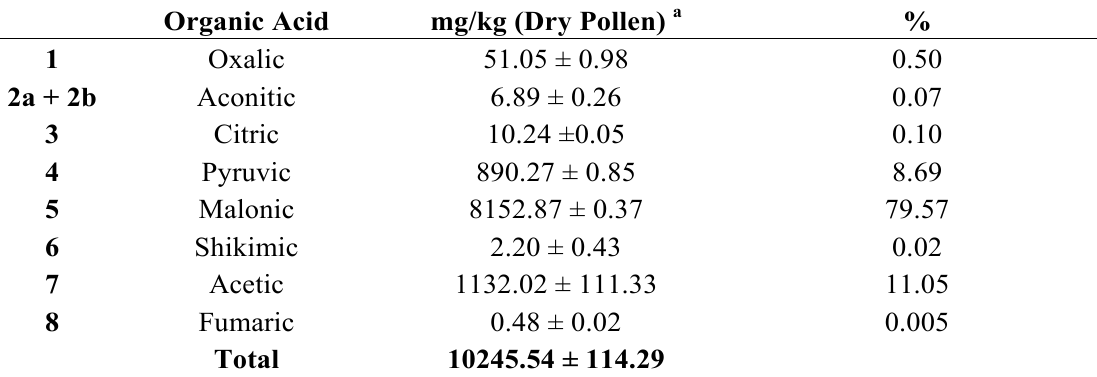
Table 1. Organic acids composition of E. plantagineum bee